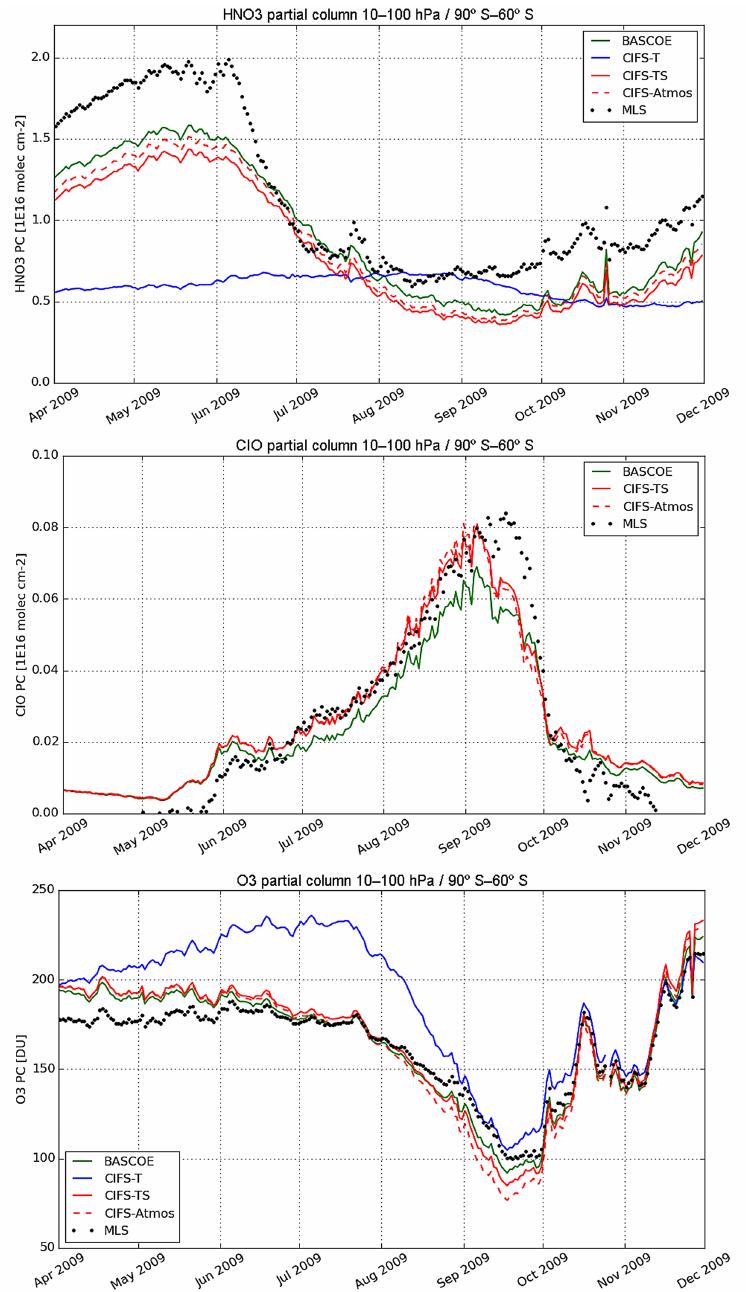
Figure 6. Daily averages of O 3 partial columns (10–100hPa) over the Antarctic (90–60 ◦ S) for the period April–November 2009 for HNO 3 (top), ClO (middle), and O 3 (bottom) against MLS